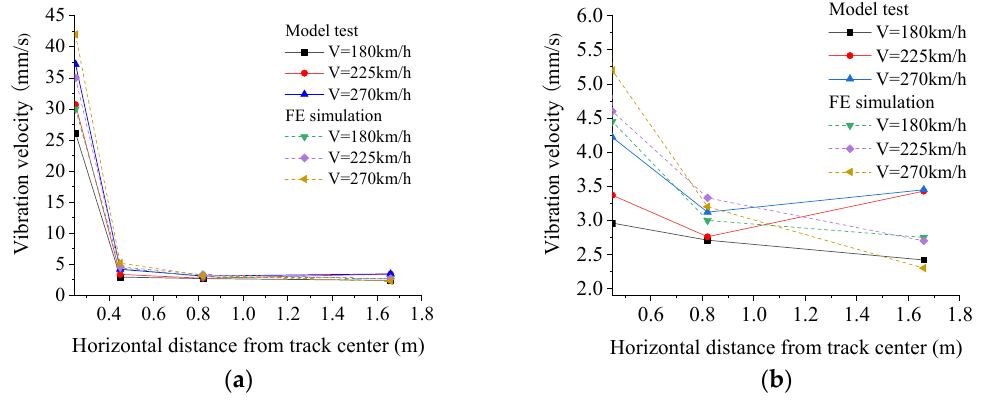
Figure 18. Comparison of the vibration velocity attenuation along the horizontal direction. ( a ) V1–V4, ( b )